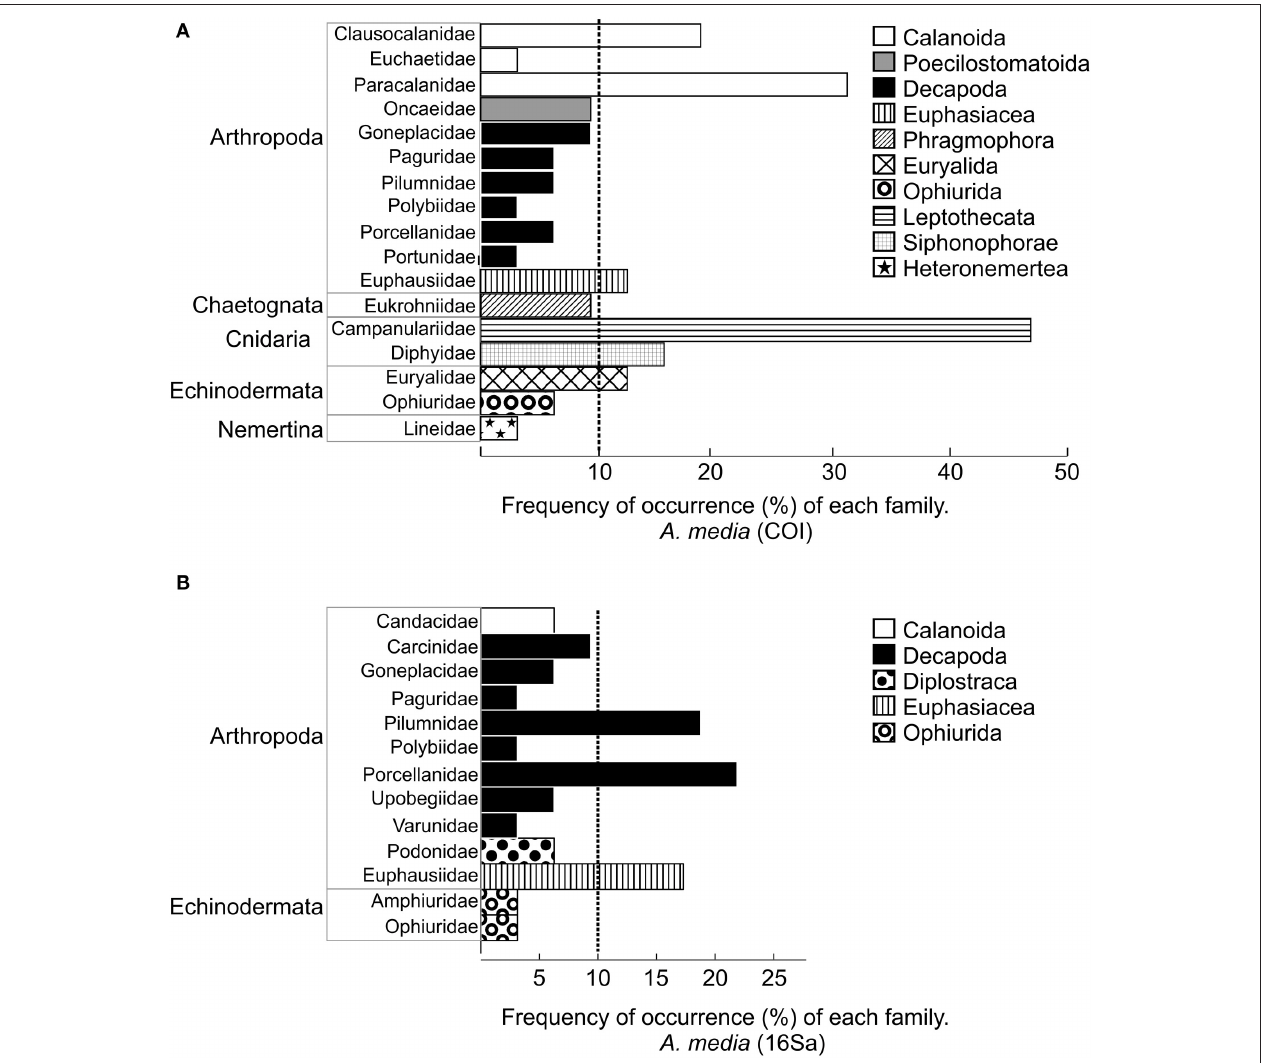
FIGURE 4 | Frequency of the occurrence of families (FF) detected in A. media with primers COI (A) and with primer 16Sa (B) . Colors represent different orders. The corresponding phylum is indicated on the left. Vertical dashed line indicates the families detected in more than 10% of paralarvae.